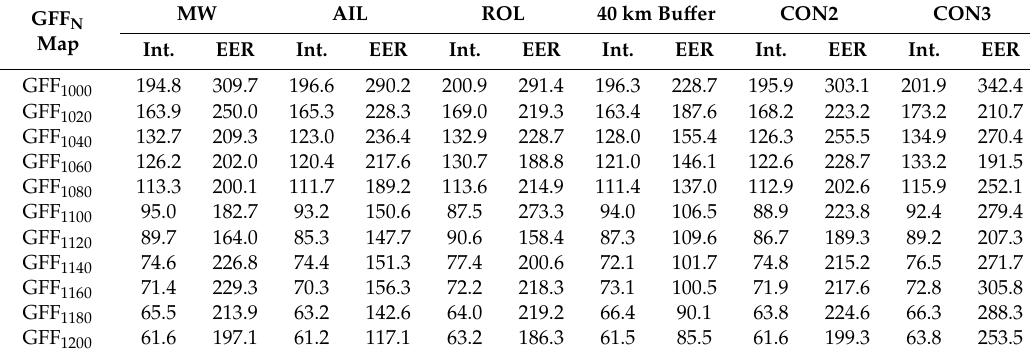
Table 3. The fire rotation (FR) estimated from the interior (Int.) and the edge e ff ected region (EER) with